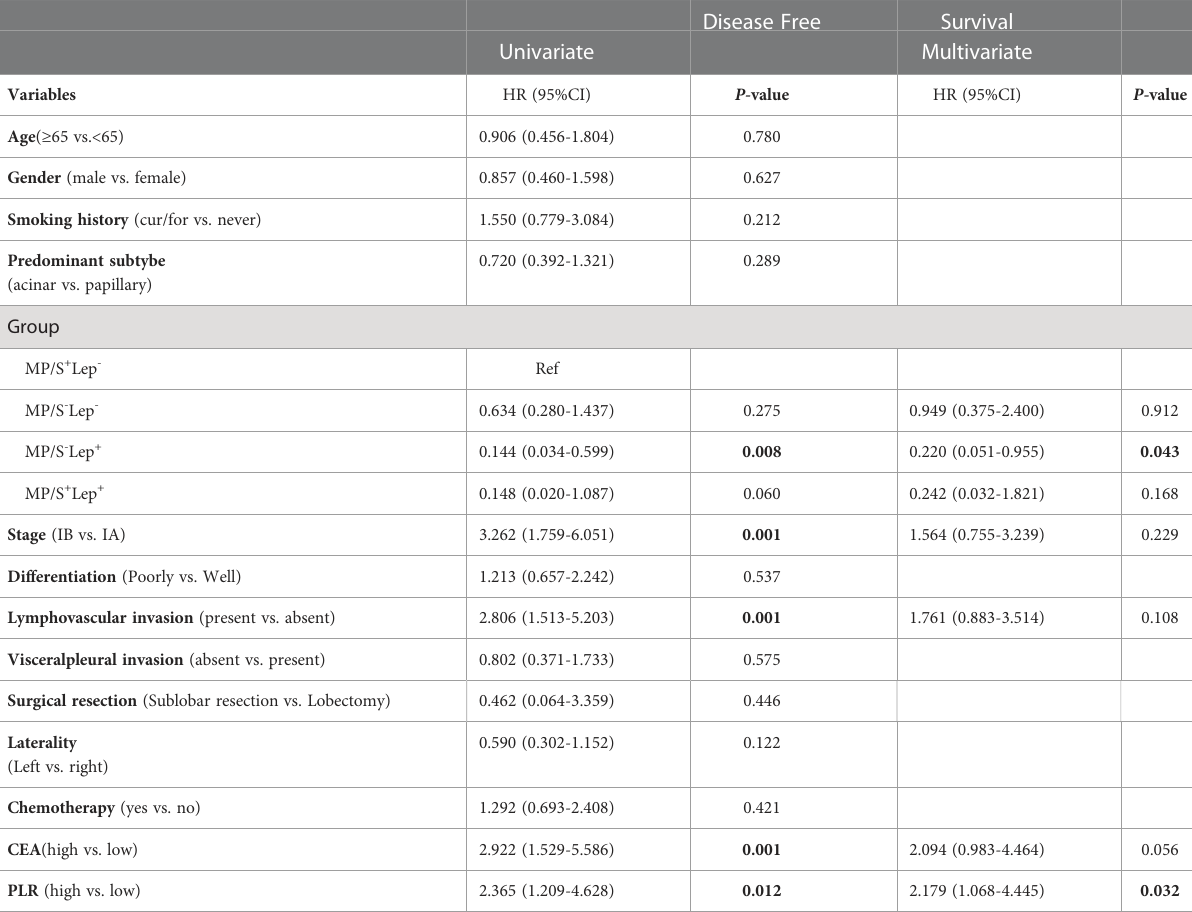
TABLE 3 Univariate and multivariate COX regression analysis for disease-free survival in stage I lung